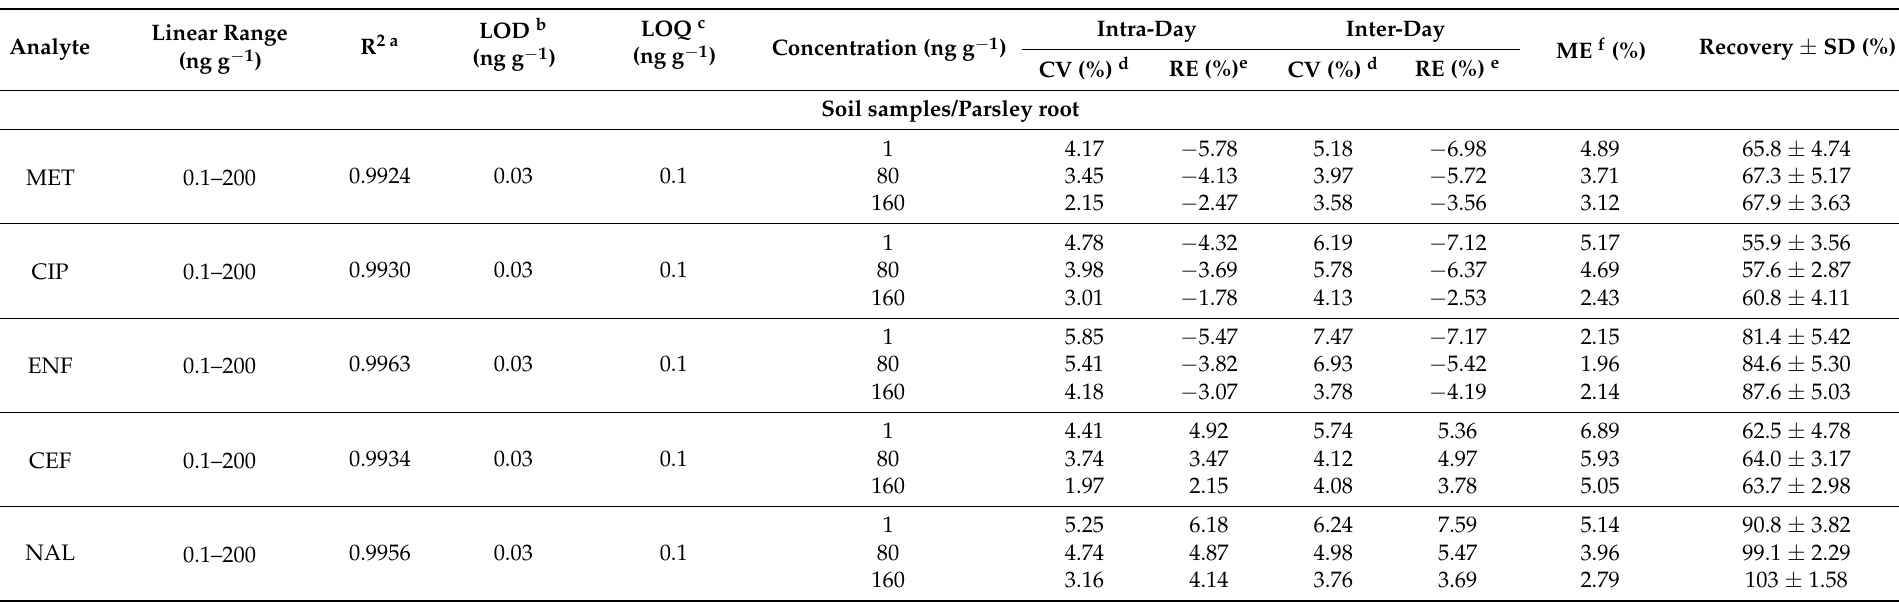
Table 4. The analytical parameters of the developed solid-liquid extraction (SLE)-solid phase extraction (SPE)-HPLC-UV-MS/MS procedure.